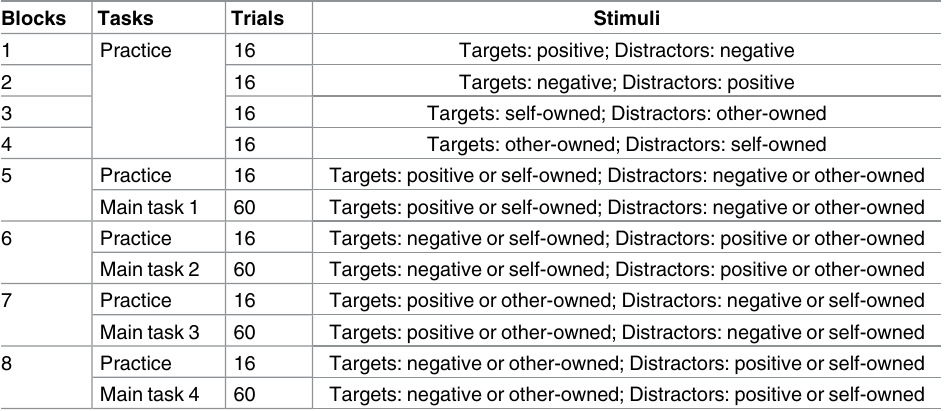
Targets: negative or other-owned; Distractors: positive or self-owned Note. Positive = positive adjectives; Negative = negative adjectives; Self-owned = self-owned objects; Other-owned = other owned objects. Words were shown on the screen one-by-one. Participants pressed the space bar for signals, and did not press any key for noises. The order of Blocks 1, 2, 3, and 4 was random, while the order of Blocks 5, 6, 7, and 8 was also